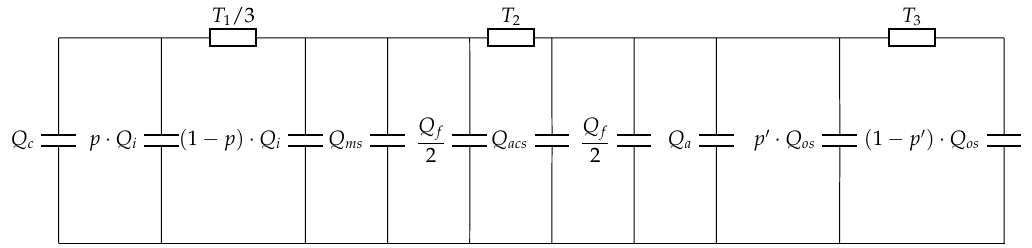
Figure 13. Thermal three-core XLPE submarine cable ladder network.